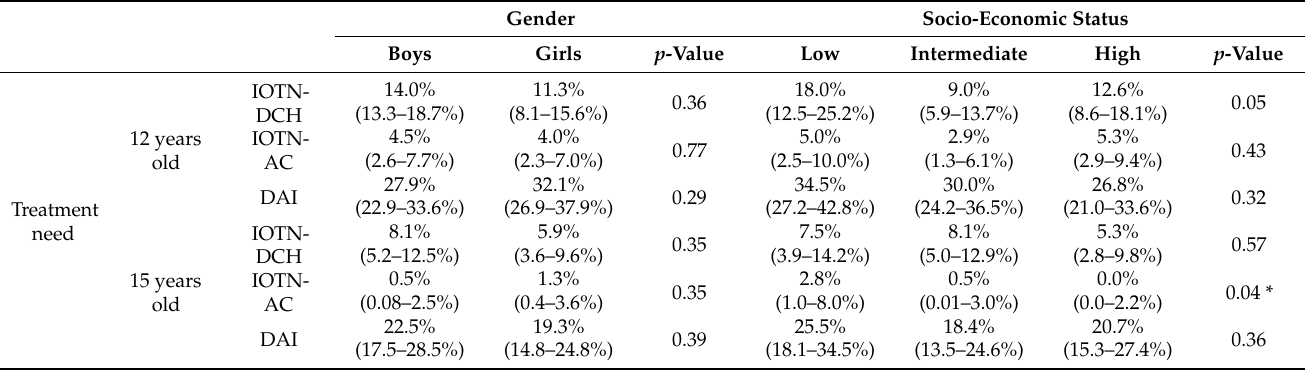
Table 4. Orthodontic treatment need according gender or socio-economic status for the groups of 12 and 15 years old. p -value Chi 2 test. * ( p <